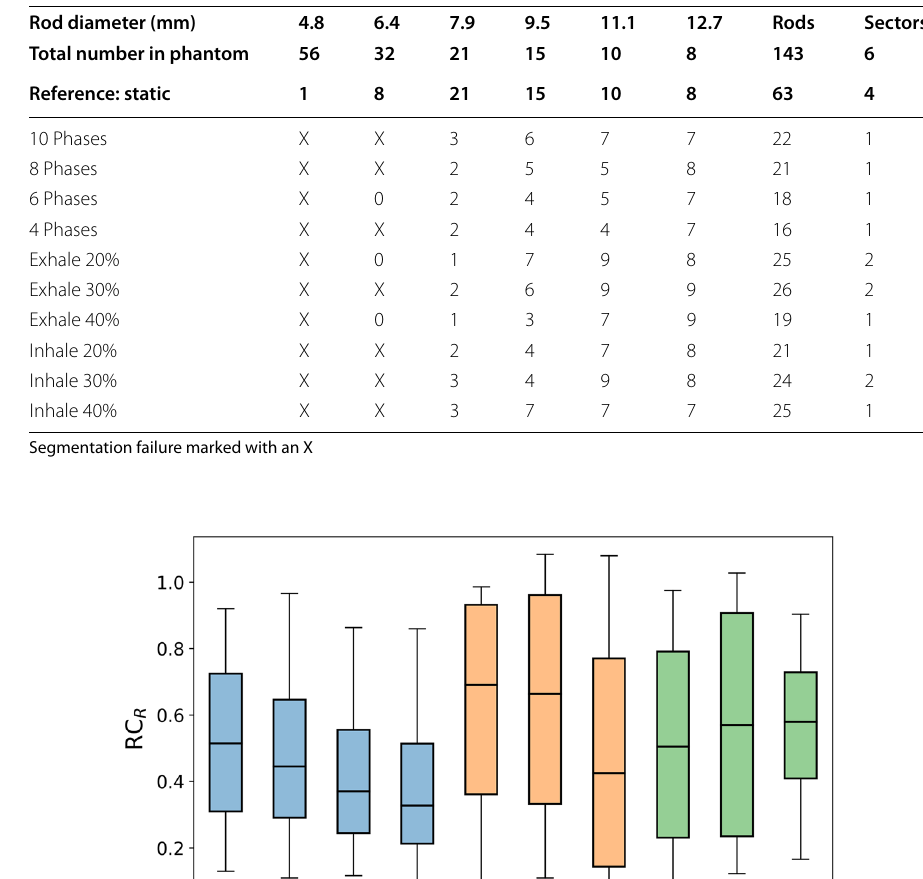
Table 2 Number of rods distinguished per protocol and per rod sector